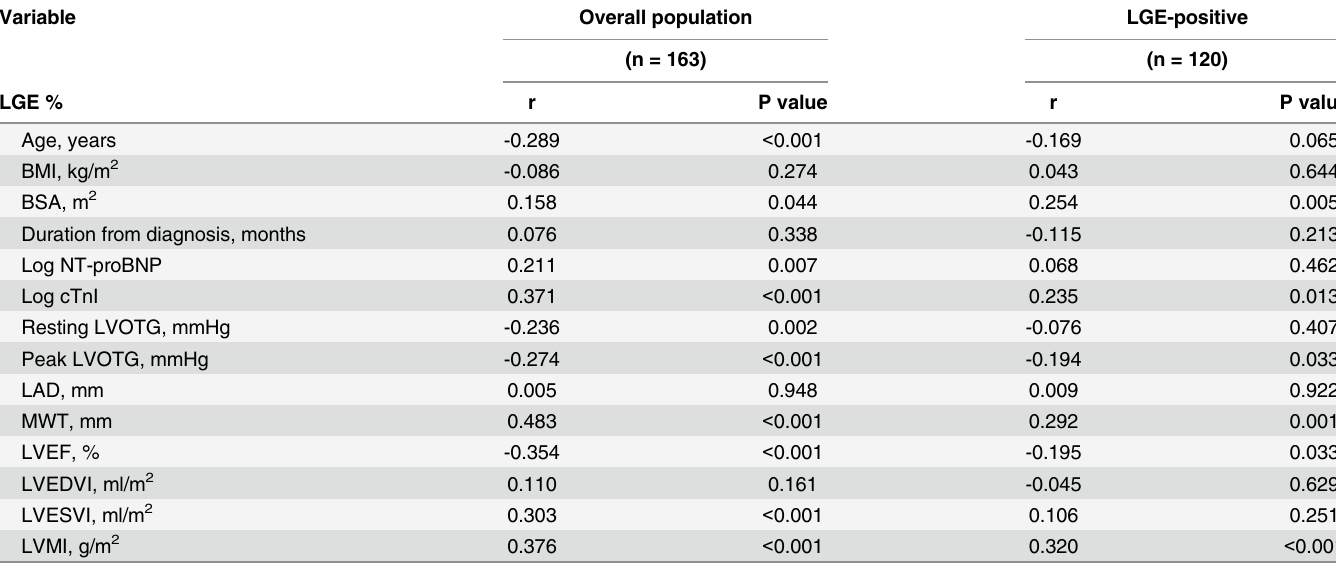
Table 3. Correlates of extent of LGE (LGE %) in the overall patients and patients with